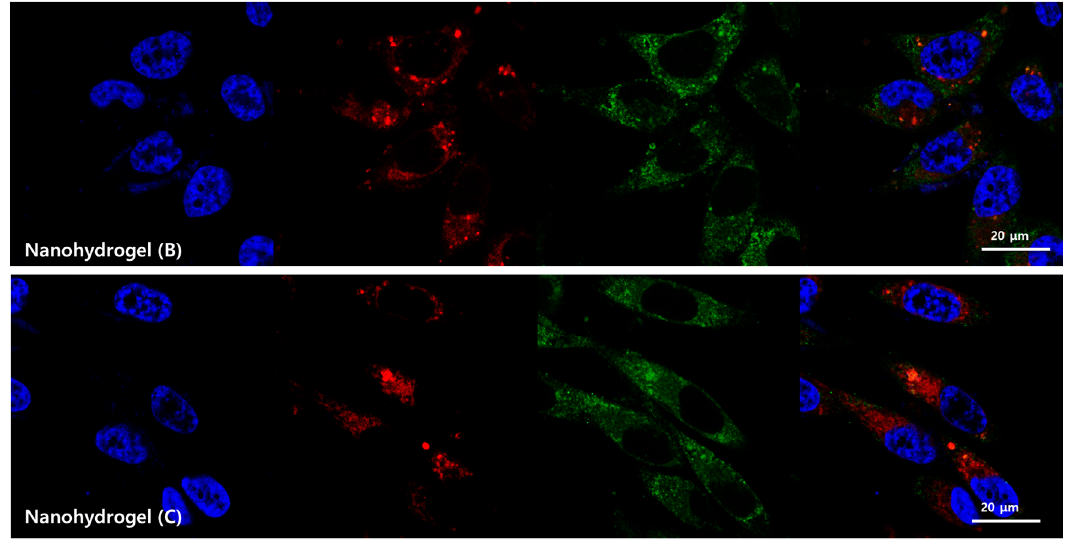
Figure 5. Confocal laser scanning microscopy (CLSM) images of the MDA-MB-231 cells incubated with the nanohydrogels for 13 h. The merged image shows the overlay of a blue filter for the cell nucleus (Hoechst 33324), a red filter for the ICG fluorescence, and a green filter for the cell cytoplasm.